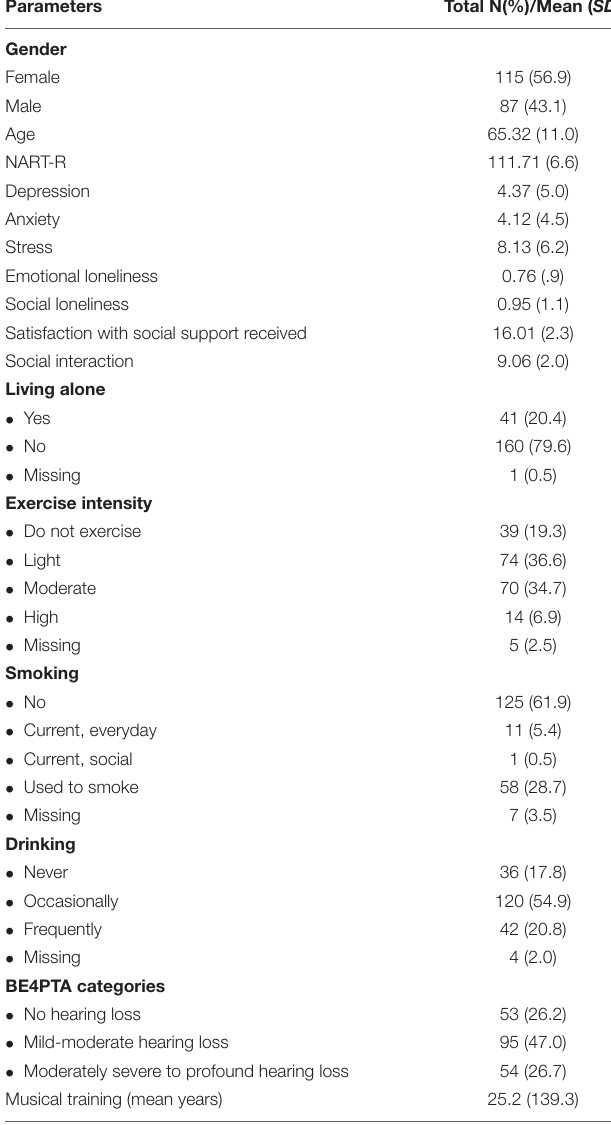
TABLE 1 | Demographic details of the